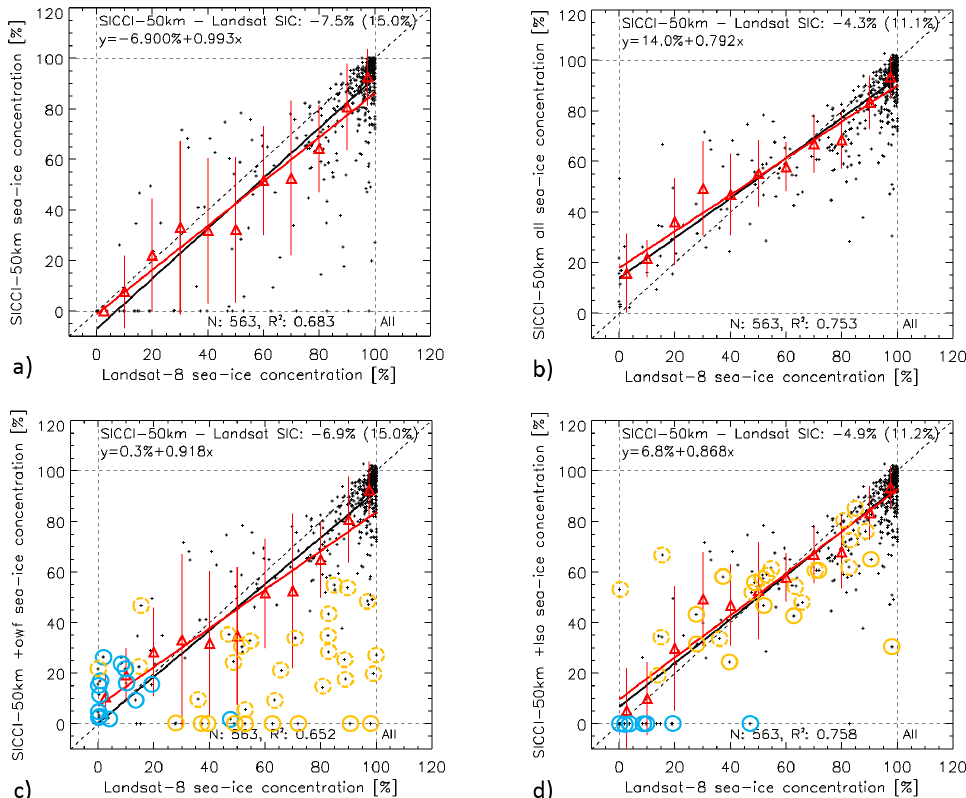
Figure 10. Scatterplots of SICCI-50km SIC ( y axis) versus Landsat SIC ( x axis) for ice regime “leads/openings” in the Southern Hemisphere in the years 2013–2015. Black dots are individual data pairs, the solid black line is the linear regression, and the dashed black line is the identity line. Red triangles denote the mean PMW SIC computed for Landsat SIC ranges 0%–5%, 5%–15%, 15%–25%, ... , 85%–95%, 95%–100%, the red bars denote 1 standard deviation of these mean values, and the red line is the respective linear regression line. The overall difference PMW SIC minus Landsat SIC, its standard deviation, and the equation for the linear regression using the individual data pairs are given at the top and the number N of data pairs and the squared linear correlation coefficient at the bottom of each panel. (a) Fully truncated SIC, all filters applied; (b) fully non-truncated SIC, no filters applied; (c) truncated/non-truncated SIC, GT100 and OWF applied; (d) truncated/non-truncated SIC, GT100 and LSO applied. Blue circles mark SICCI-50km SIC values set to 0% by the OWF; orange circles mark SICCI-50km SIC values changed by the LSO (solid circle: SIC set to 0%; broken circle: SIC